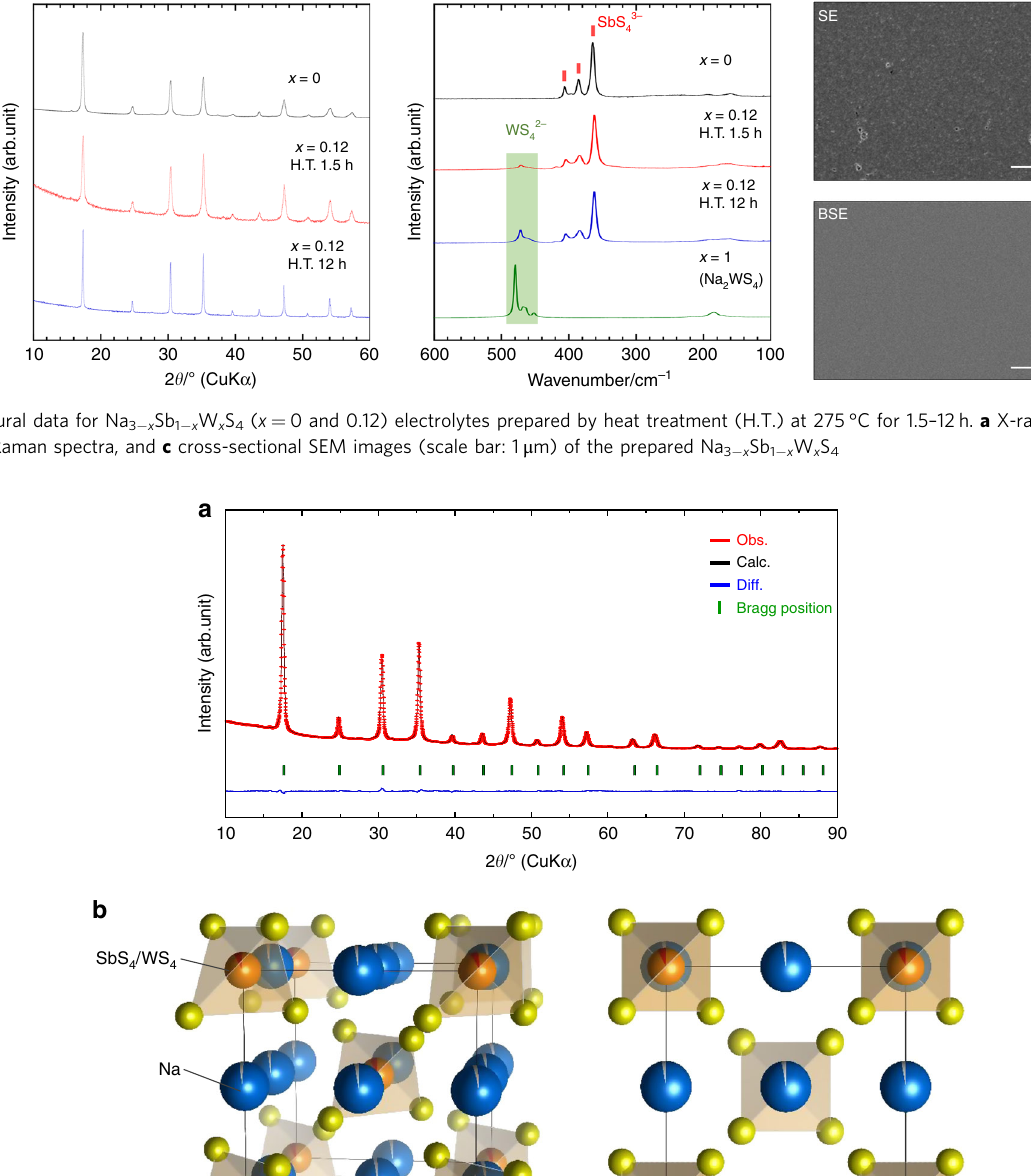
Fig. 2 Crystal structure of Na 2.88 Sb 0.88 W 0.12 S 4 heated at 275 °C for 12 h. a Rietveld re fi nement pro fi les of X-ray powder diffraction data for Na 2.88 Sb 0.88 W 0.12 S 4 . Red dots and black lines denote the observed and calculated XRD patterns, respectively. The green sticks mark the position of the re fl ections for Na 2.88 Sb 0.88 W 0.12 S 4 . The difference between the observed and calculated patterns is indicated by the blue line. b Crystal structure of cubic Na 2.88 Sb 0.88 W 0.12 S 4 with the unit cell outlined. The Na, Sb, W, and S sites are represented by blue, orange, gray, and yellow balls, respectively. Na is linearly arranged, and distortion of the Sb 4 /WS 4 tetrahedra is very small compared to the tetragonal structure of Na 3 SbS 4 (Supplementary Fig.